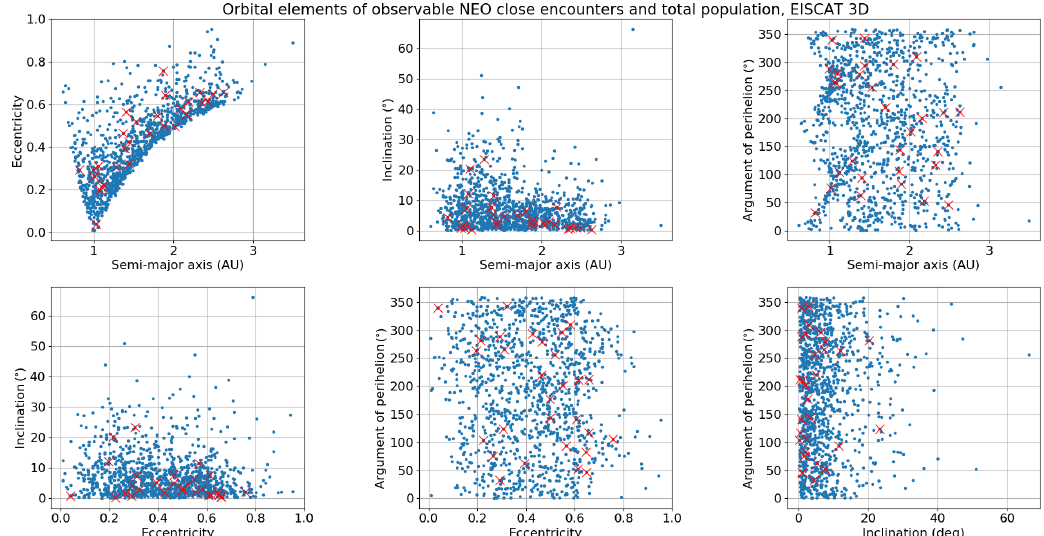
Figure 6. Orbital elements of CNEOS database for the period 13 March 2019 to 13 March 2020, with objects having close approaches to the Earth and being simultaneously observable from the E3D facility, marked with red